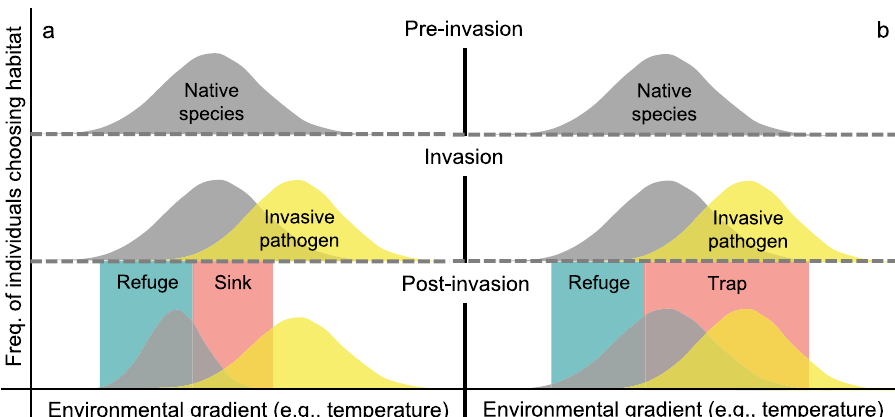
Fig. 1 Habitat refugia, sinks, and traps for native species. Before invasion, individuals are distributed across environmental gradients such that habitat preferences generally match habitat suitability. Invasive species can cause some or all habitats along an environmental gradient to become unsuitable for native species ’ survival or reproduction, and ( a ) individual preferences may change with suitability due to learning or selection. However, ( b ) native species may also continue to prefer unsuitable habitats, and these habitats will become ecological traps after invasion. Whether preferences change or not, native species ’ post-invasion distributions might be shifted towards habitat refugia where invasive species cannot colonize or negative species interactions are suf fi ciently mediated by environmental